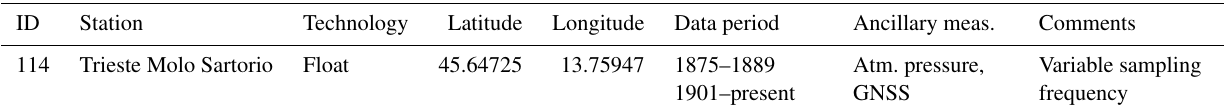
Table A10. Station operated by CNR-ISMAR at Trieste, Italy.